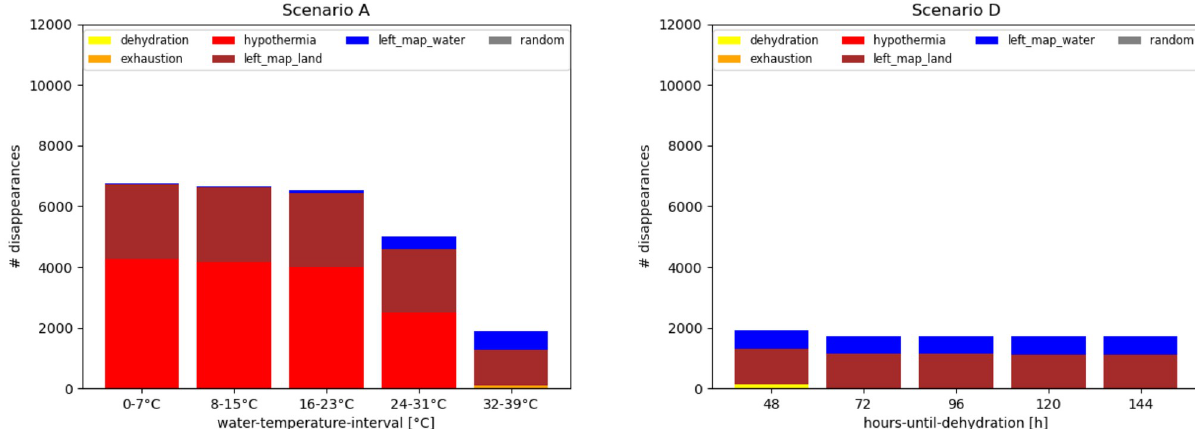
Fig 8. Disappearance of agents during simulation runs. An example of Scenario A, when varying the temperature of the water (left) and an example of Scenario D (right), when varying the hours until dehydration, are shown. Agents may die of dehydration, hypothermia or exhaustion, but may also leave the map at the border across land (left_map_land) or across water (left_map_water).